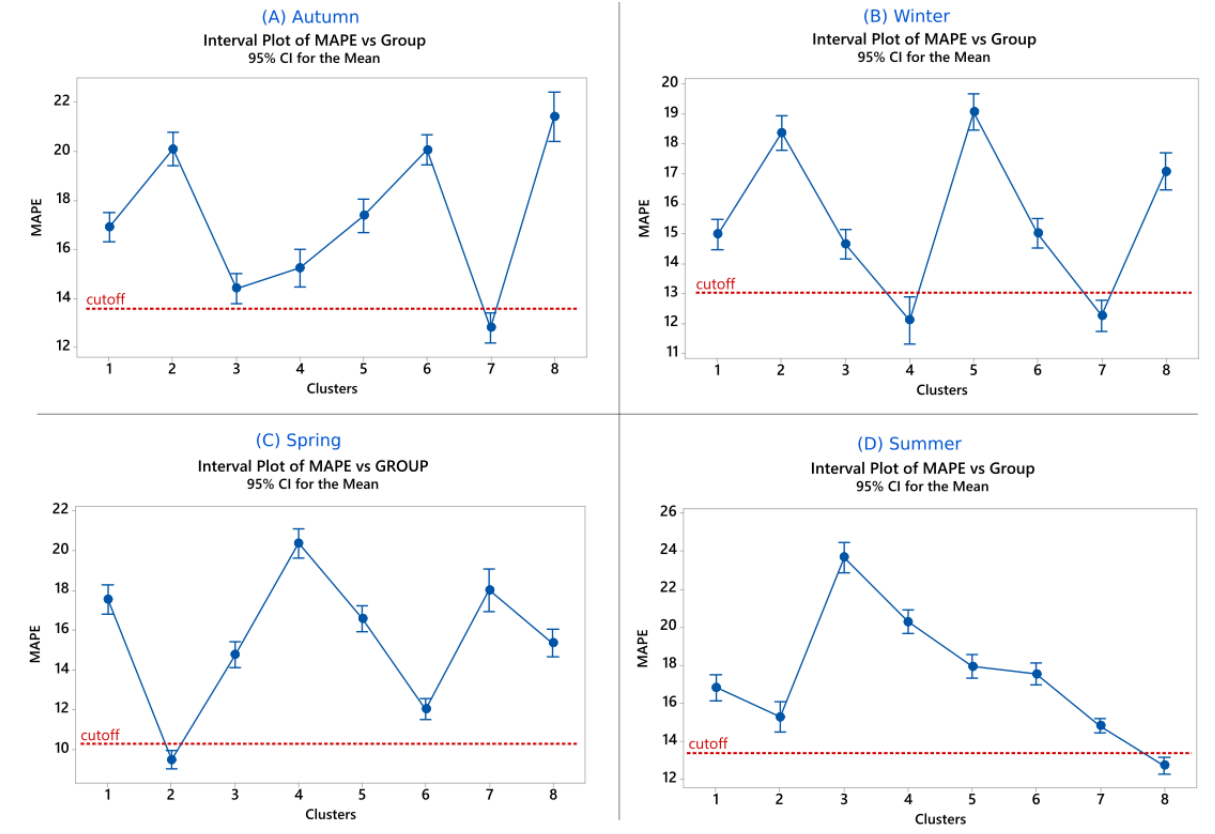
Figure 13. Main effects plot for each season, considering the average error of all seventeen generation plants. Source: own authors.